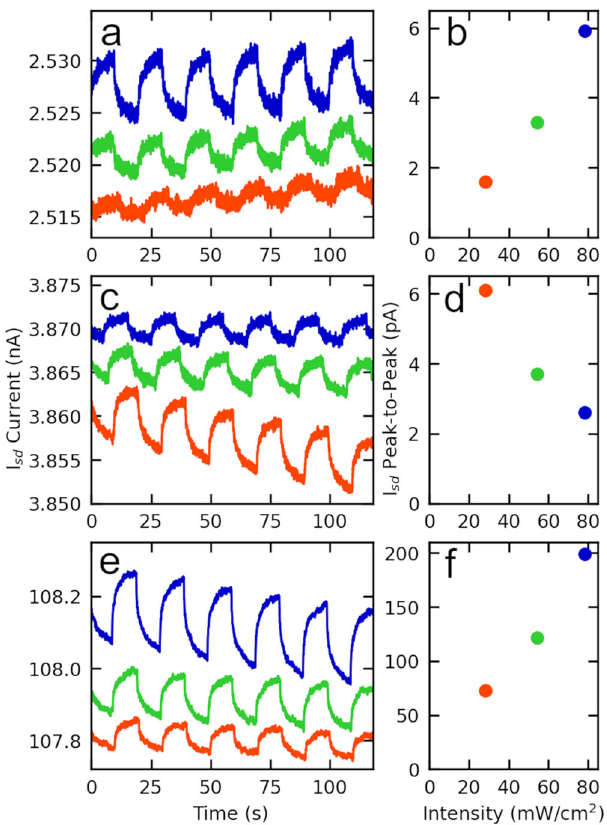
Fig. 6 Photoconductivity vs. time as the excitation laser is repeatedly switched on/off and peak-to-peak photocurrent current vs. laser excitation intensity, respectively, for various NP fi lms and X-NS. a , b benzenethiol NP fi lm, ( c , d ) benzenedithiol X-NS, and ( e , f ) terphenyldithiol X-NS. Excitation laser power/area and wavelengths are 78.2 mW cm − 2 at 473 nm (blue data/top curves in ( a , c , e ) offset by ∼ + 0.2% for clarity), 54.3 mW cm − 2 at 520 nm (green data/middle curves in ( a , c , e ) and 28.2 mW cm − 2 at 638 nm (red data/bottom curves in ( a , c , e ) offset by ~ – 0.2% for clarity). The spot diameter in all cases is ~3 mm. Current is measured using 2 probes and 2 V applied